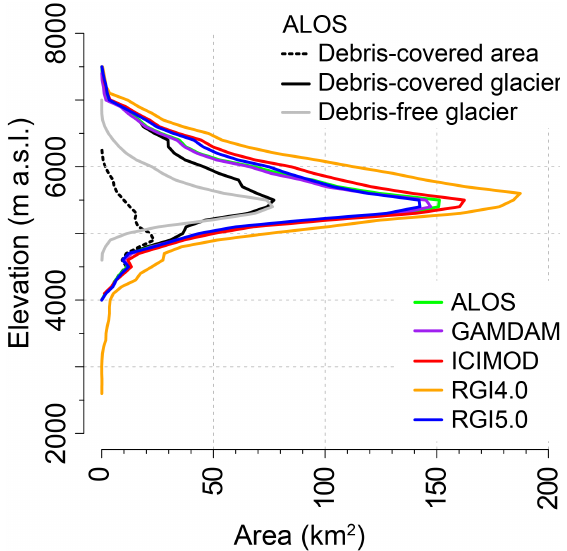
Figure 9. Hypsographic curves of glacier surfaces from the ALOS, GAMDAM, ICIMOD, RGI4.0, and RGI5.0 inventories. Also shown are the curves for the debris-covered area, and the debris-covered and debris-free glaciers, extracted from the ALOS